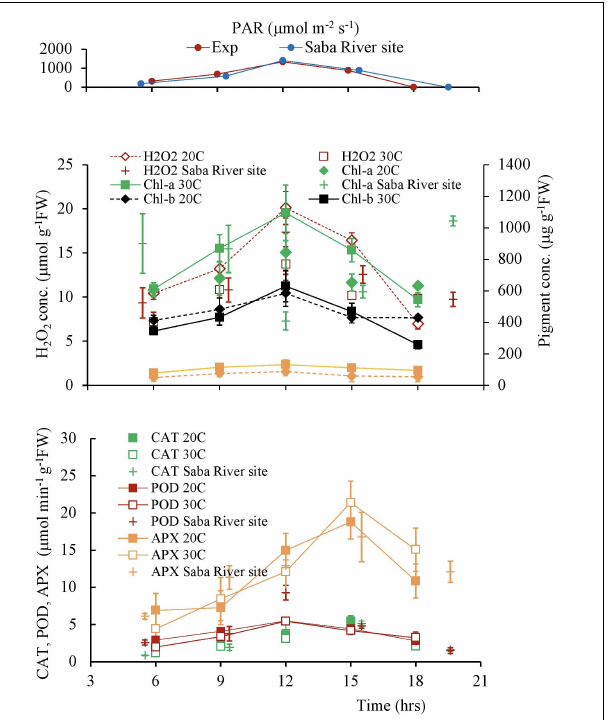
FIGURE 11 | The variation patterns of the solar radiation, H 2 O 2 concentration, and antioxidant activities of plant tissues in a day. Vertical bars indicate the standard